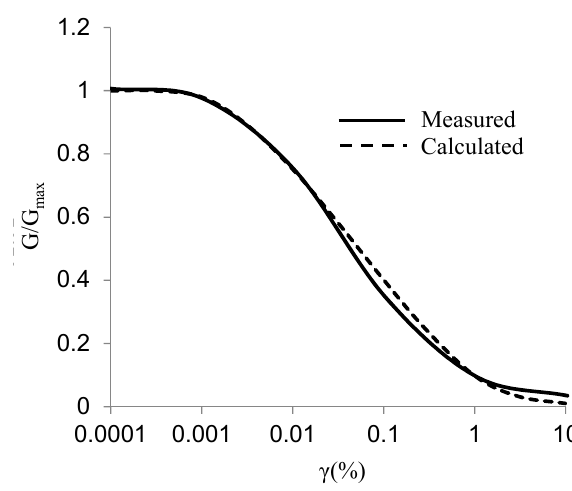
Figure 3. Curve fitting of G / G max curve of model sands.